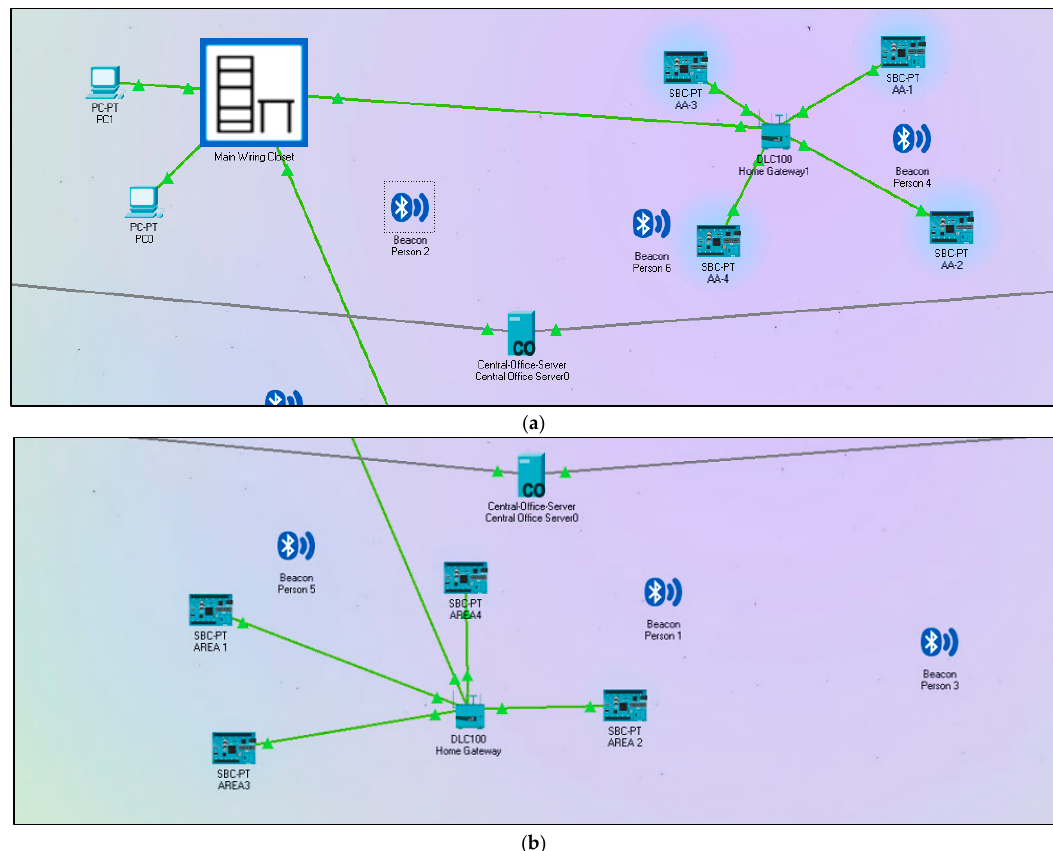
Figure 8. Position of SBC and random distribution of BLE devices inside the mine area ( a , b ).